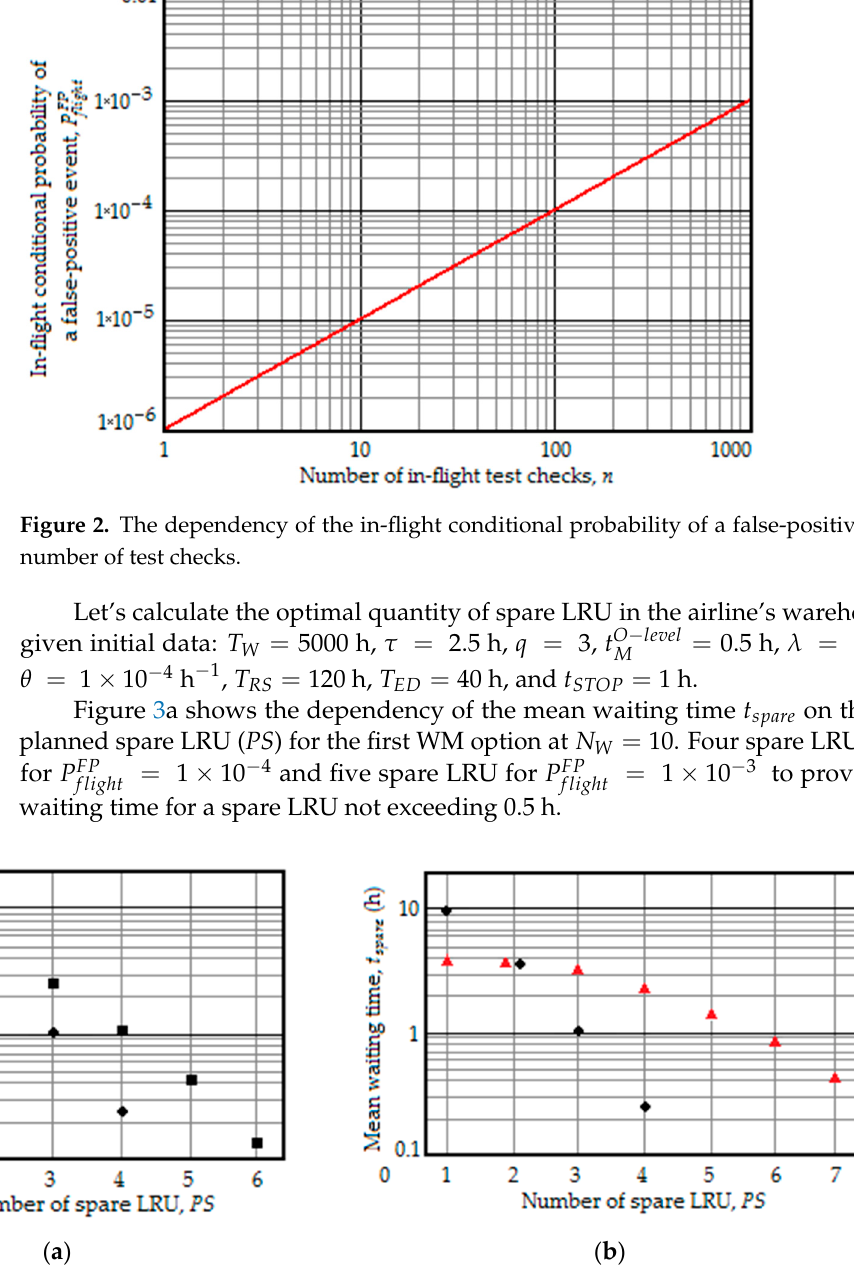
Figure 3. Dependences of the mean waiting time on the number of planned spare LRU ( PS ) for the first WM option; ( a ) circles: 𝑃 (cid:3033)(cid:3039)(cid:3036)(cid:3034)(cid:3035)(cid:3047)(cid:3007)(cid:3017) = 1 × 10 (cid:2879)(cid:2872) , squares: 𝑃 (cid:3033)(cid:3039)(cid:3036)(cid:3034)(cid:3035)(cid:3047)(cid:3007)(cid:3017) = 1 × 10 (cid:2879)(cid:2871) ; ( b ) black circles: 𝜃 = 1 × 10 (cid:2879)(cid:2872) h (cid:2879)(cid:2869) , red triangles: 𝜃 = 1 × 10 (cid:2879)(cid:2871) h (cid:2879)(cid:2869) .